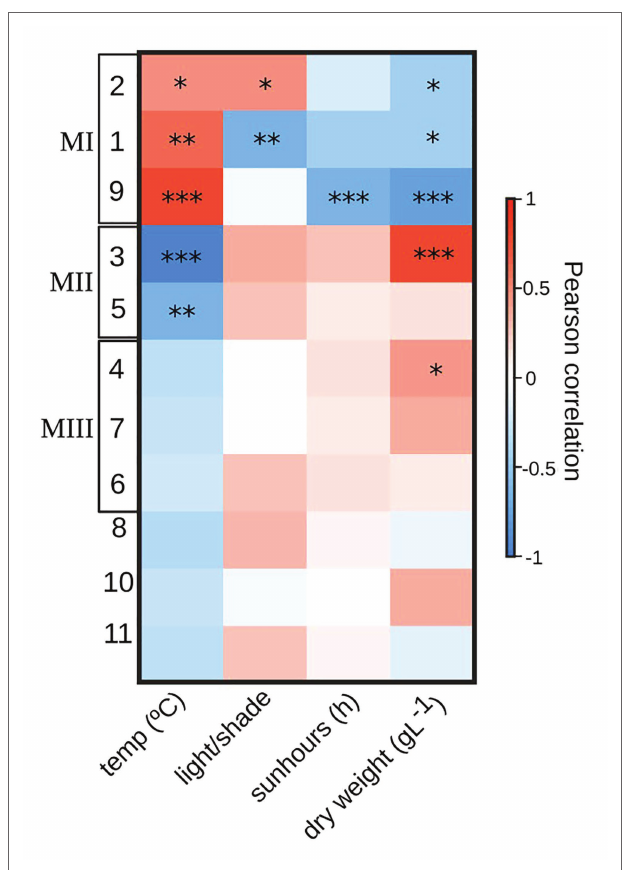
FIGURE 8 | Pearson coefficient correlation values (red – positive; blue – negative) of network analysis modules with parameters: temp – temperature ( ° C); light/shade – induced shade (40–60% reduction of light); sunhours (h) – number of hours day −1 with sunshine; Dry weight – of biomass (gl −1 ). Significances indicated by * p < 0.05, ** p < 0.01, and *** p ≤ 0.001. Module groups (MI, MII, and MIII) were based on shared edges ( Figure 7 ) and similarity in correlation to